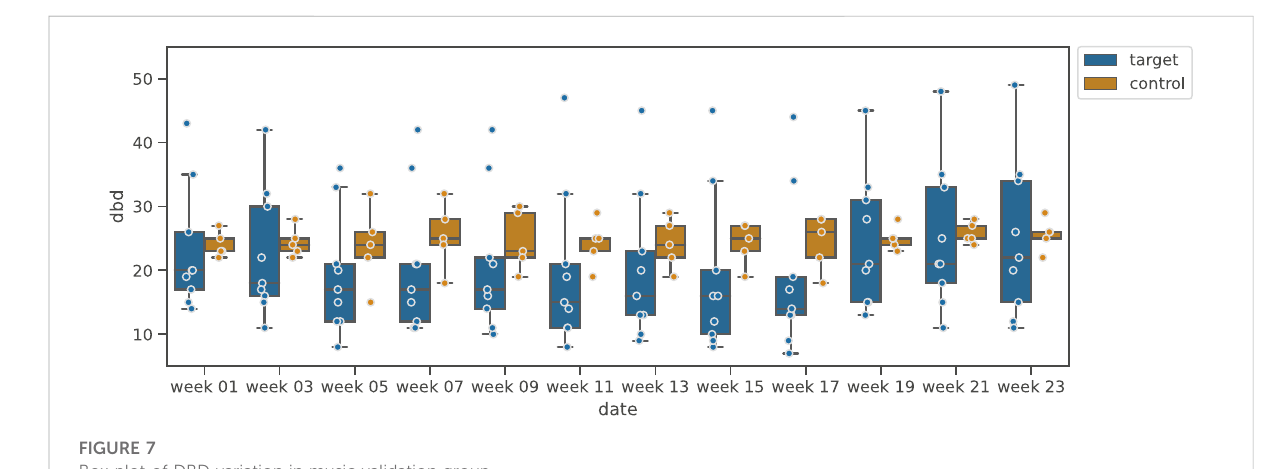
FIGURE 6 Box plot of MMSE variation in music validation group.